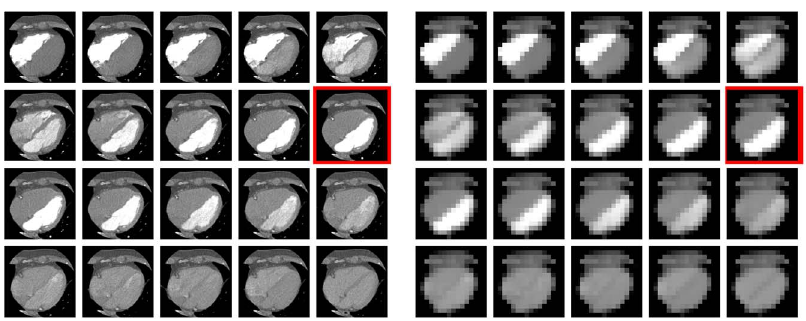
Fig. 3. Example of an image series of one patient without shrinking (a) and with shrinking to a matrix size of 16 6 16 (b). All images are in axial view. The series (from top left to right) starts with already high contrast in the RV. RV contrast is low again when the LV has high contrast. The algorithm also provides a suitable phase when information in the input images is marked reduced as in (b). The 10th phase (red border) is the phase detected by the findLV